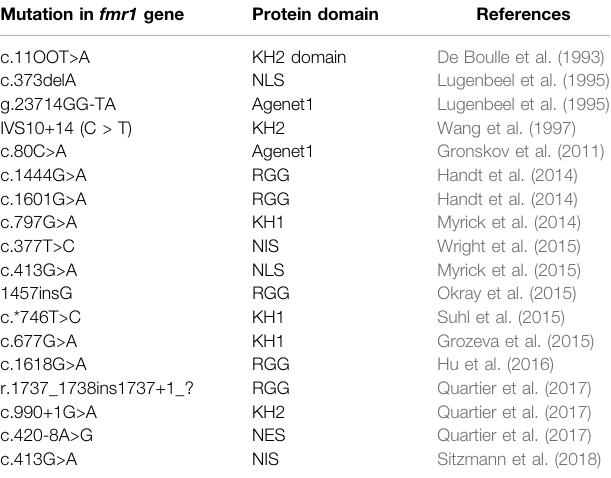
TABLE 1 | List of missense mutation in fmr1